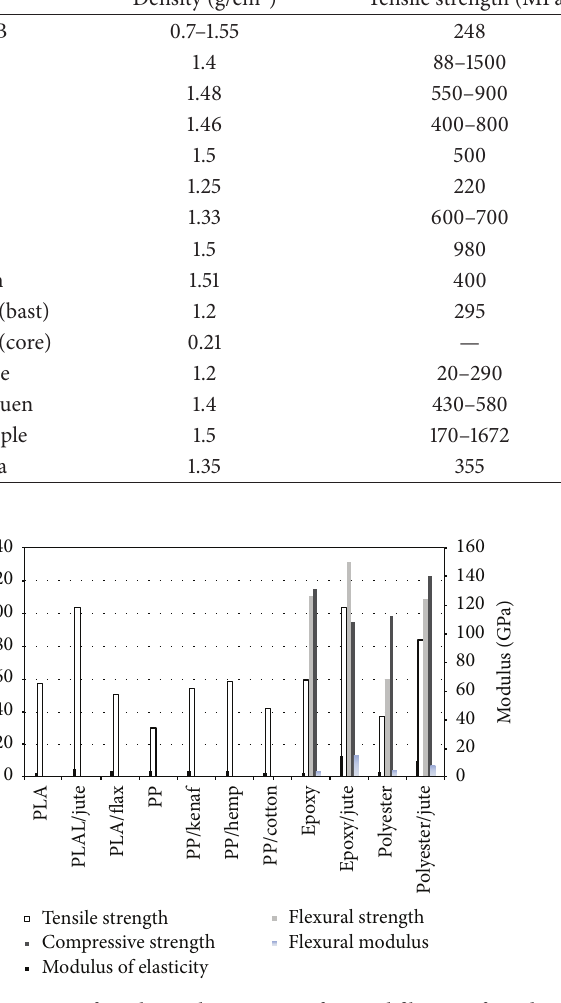
Figure 1: Some of mechanical properties of natural fiber reinforced polymer composite